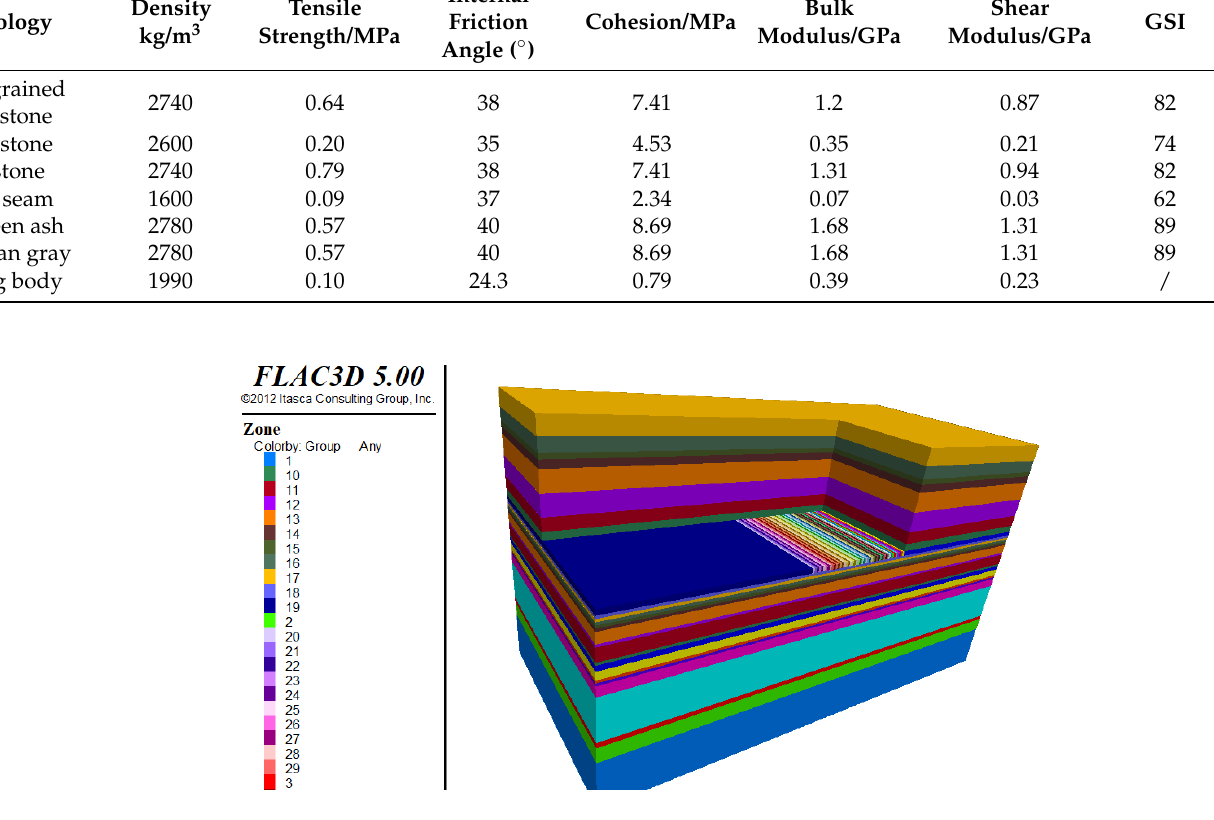
Figure 7. Abutment pressure in front of coal wall of the paste-filling face under different filling steps. ( a ) Filling step distance 1 m, ( b ) Filling step distance 2 m, ( c ) Filling step distance 3 m, ( d ) Filling step distance 4 m. The stress of the floor of the paste-filling working face is shown in Figure 7. It can be seen that the stress on the floor above the work surface presents a general law that first increases suddenly and then gradually decreases to the original rock stress. The stress concentration of the floor in front of the coal body is often caused by the excavation of the coal mass, which is also the location where the floor failure begins to occur. The peak stress of the floor shows a regular change with the change of the filling step and the advancing distance. Figures 8 and 9 are obtained by fitting the maximum stress of the floor under different advancing distances and different filling steps.